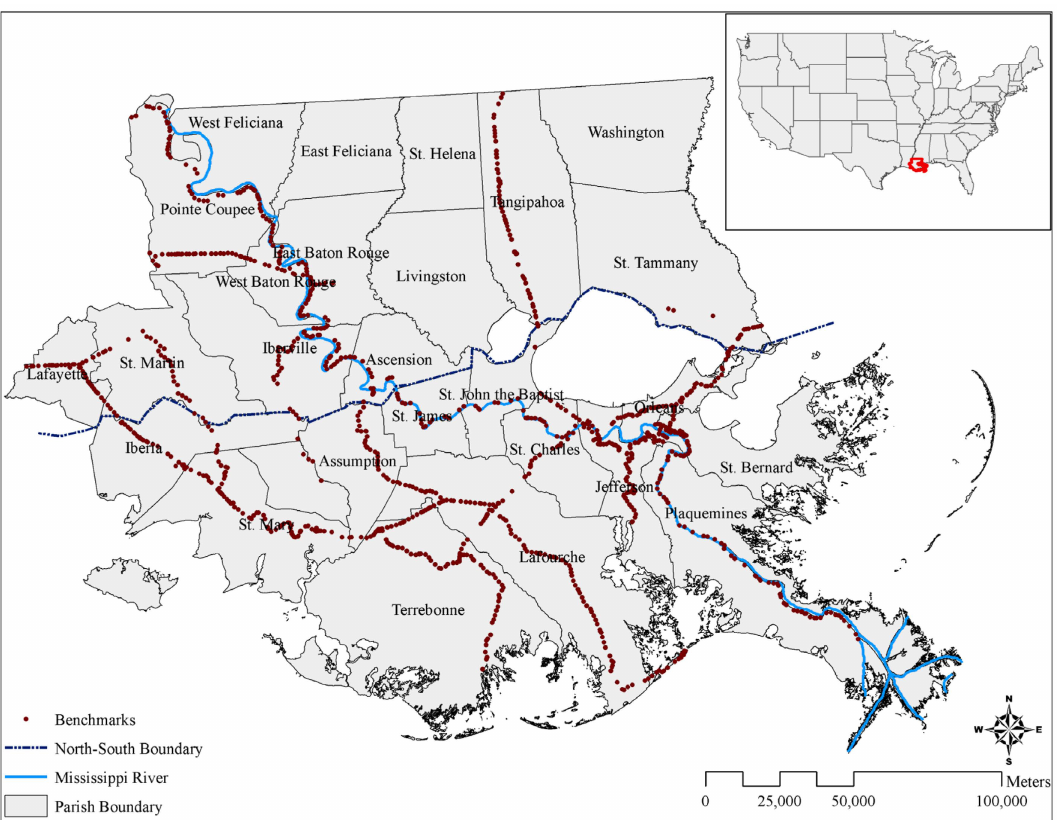
Figure 1. The Lower Mississippi River Basin